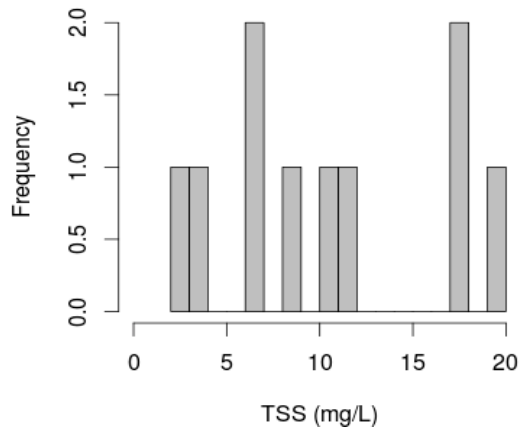
Figure 4. Frequency distribution of TSS (mg/L) concentrations. Two groups of field sample were distinguished: low or moderate TSS concentrations (TSS < 15 mg/L) and high TSS concentrations (TSS > 15 mg/L).